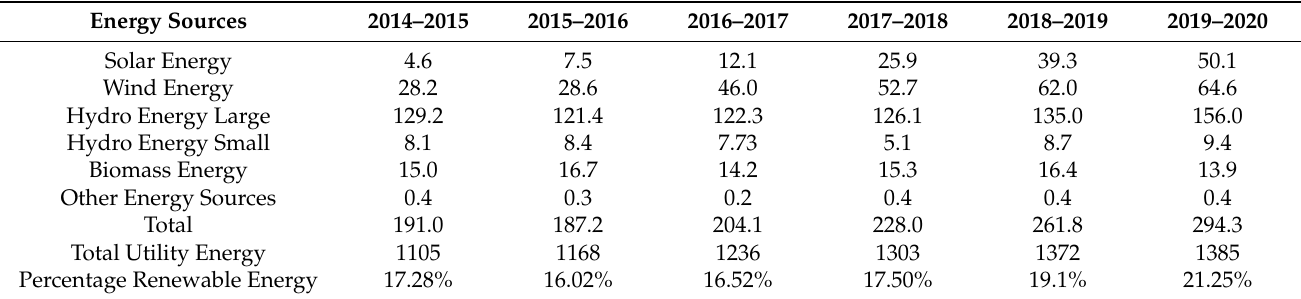
Table 4. Renewable energy generation trend in